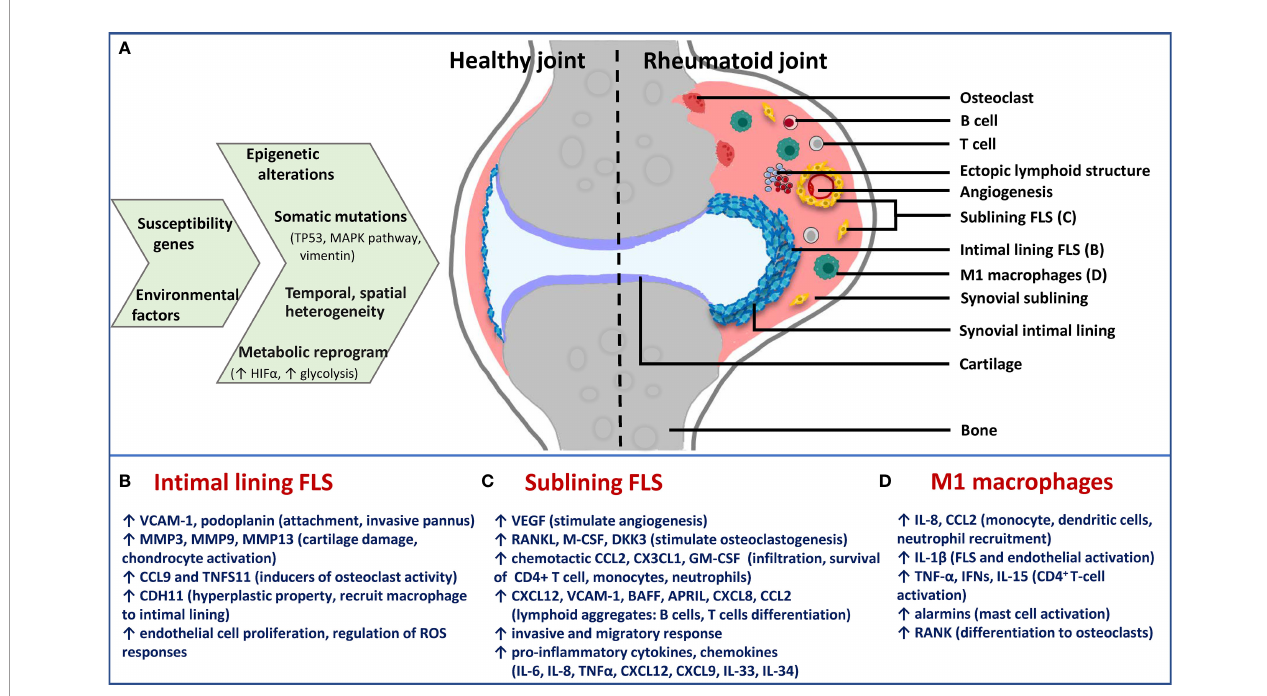
FIGURE 2 | Schematic presentation of cause-effect relationship in RA synovium with speci fi c focus on FLS phenotypes. (A) Epigenetic and metabolic reprogramming in resident and in fi ltrated cell types leads to spatiotemporal and functional heterogeneity in rheumatoid synovium. Difference between healthy and rheumatoid joint is diagrammatically depicted to illustrate changes in synovial architecture like increased angiogenesis and formation of ectopic lymphoid structures, as well as the different cell types. Functionally distinct fi broblast subsets: (B) Lining FLS; (C) sublining FLS; as well as (D) in fl ammatory (M1) macrophages are the major players in chronic RA. For each of them, effector functions via secreted in fl ammatory and destructive mediators are mentioned below the diagram. Immune- effector fi broblasts and macrophages of sublining are responsible for accelerating in fl ammatory feed-forward loops, whereas lining fi broblasts mediate bone and cartilage damage. TP53, tumor protein p53; MAPK, mitogen-activated protein kinase; HIF a , hypoxia-inducible factor alpha; FLS, fi broblast-like synoviocytes; M1, in fl ammatory; VCAM-1, vascular cell adhesion molecule 1; MMP, matrix metalloproteinase; CCL, chemokine (C-C motif) ligand; CDH11, cadherin 11; VEGF, vascular endothelial growth factor; RANKL, receptor activator of nuclear factor kappa-B ligand; M-CSF, macrophage colony-stimulating factor; DKK3, dickkopf WNT signaling pathway inhibitor 3; CXCL, chemokine (C-X-C motif) ligand; GM-CSF, granulocyte-macrophage colony stimulating factor; BAFF, B-cell activating factor; APRIL, a proliferation-inducing ligand; IL, interleukin; TNF- a , tumor necrosis factor